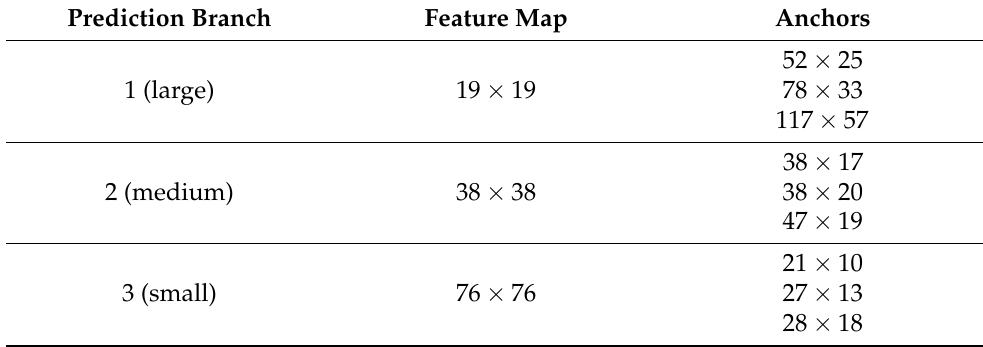
Table 2. Size of the